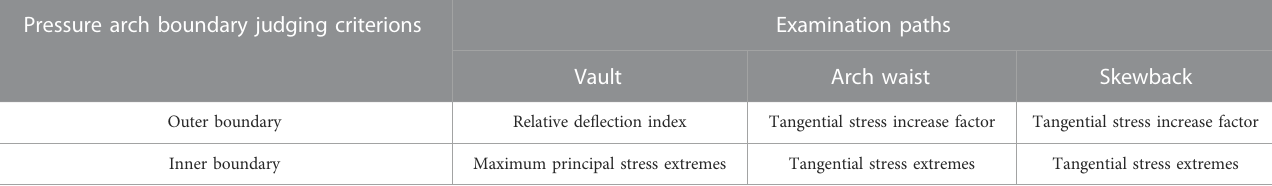
TABLE 2 Criterions for the application of different stress examination paths. Pressure arch boundary judging